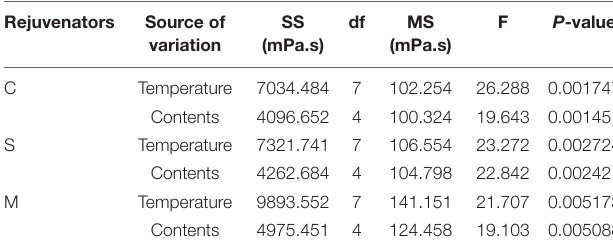
TABLE 8 | Two-factor ANOVA on the G*sin δ of recovered bitumen ( α =